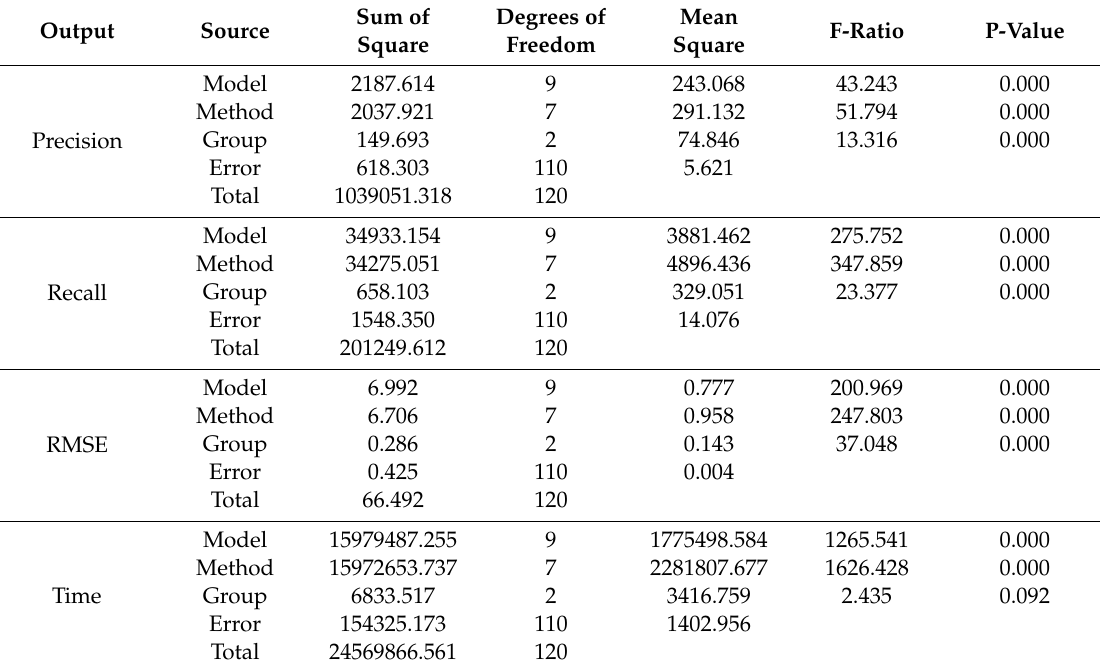
Table 11. Two-way ANOVA for precision, recall, RMSE, and matching time.